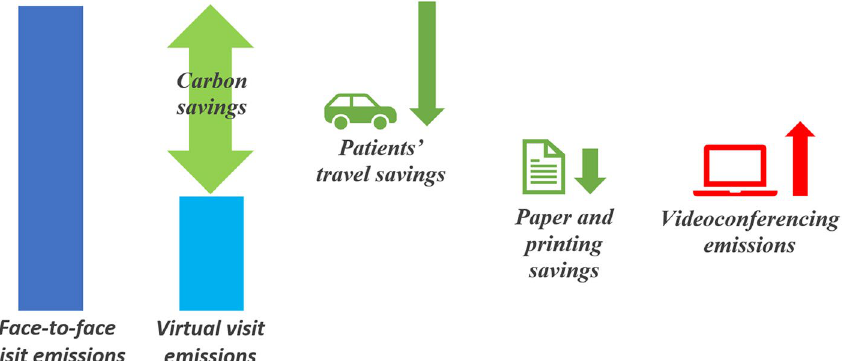
Figure 2. Calculation of carbon savings of performing a visit online. The net carbon savings of performing a visit online were calculated by summing the carbon savings derived from the avoided patient travel and document printing and subtracting the videoconferencing